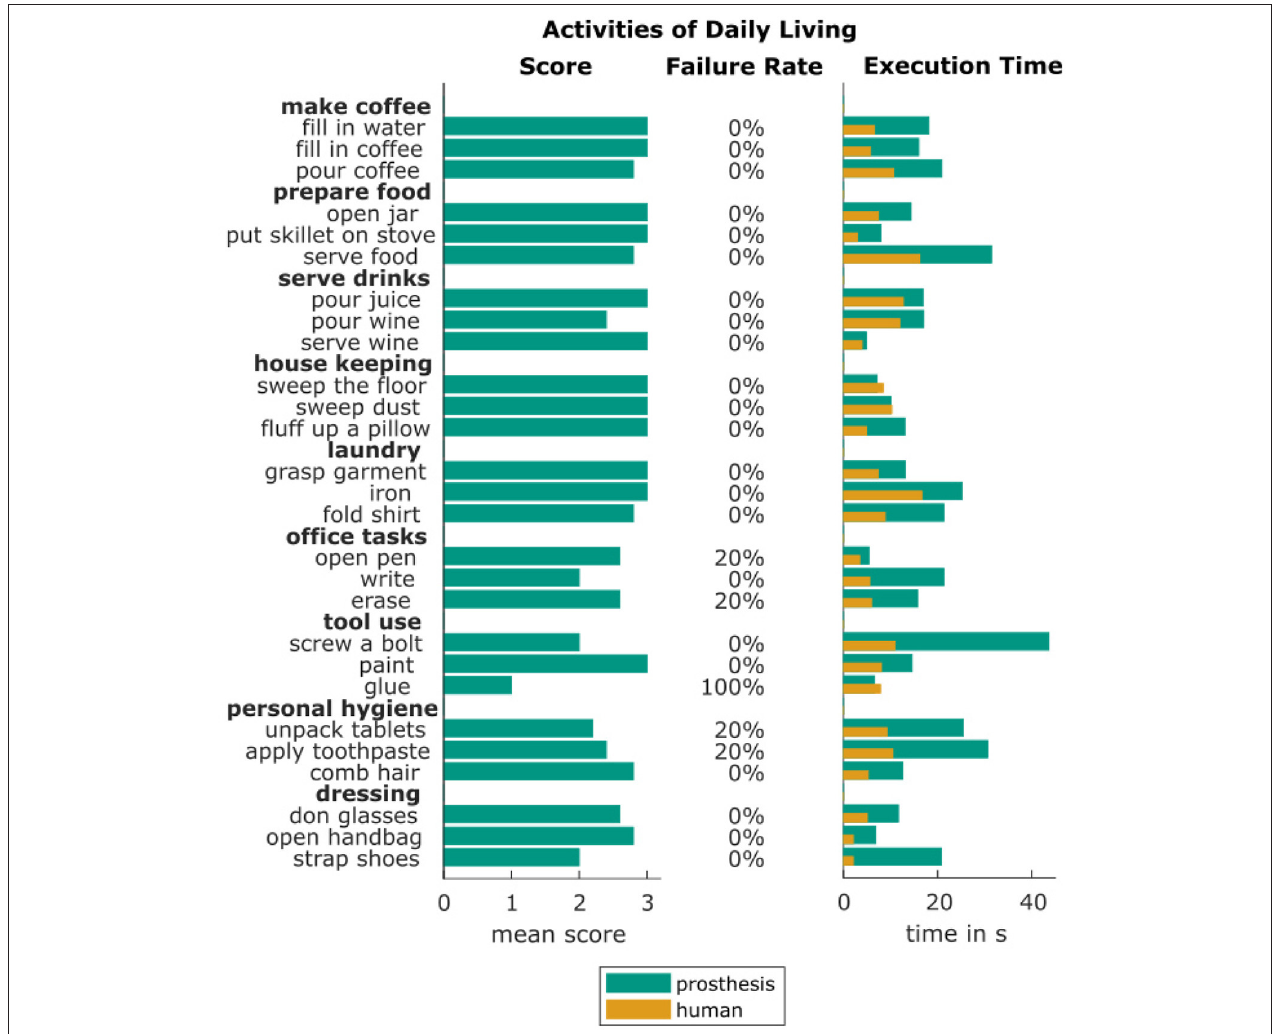
FIGURE 8 | Tasks performed in the task-oriented protocol with the mean prosthesis scores, ranging between 0 for the hand being unable to grasp the object to 3 for a comfortable task execution, the rate of failed task executions over five trials and the mean execution times with the prosthetic hand and an able human hand.